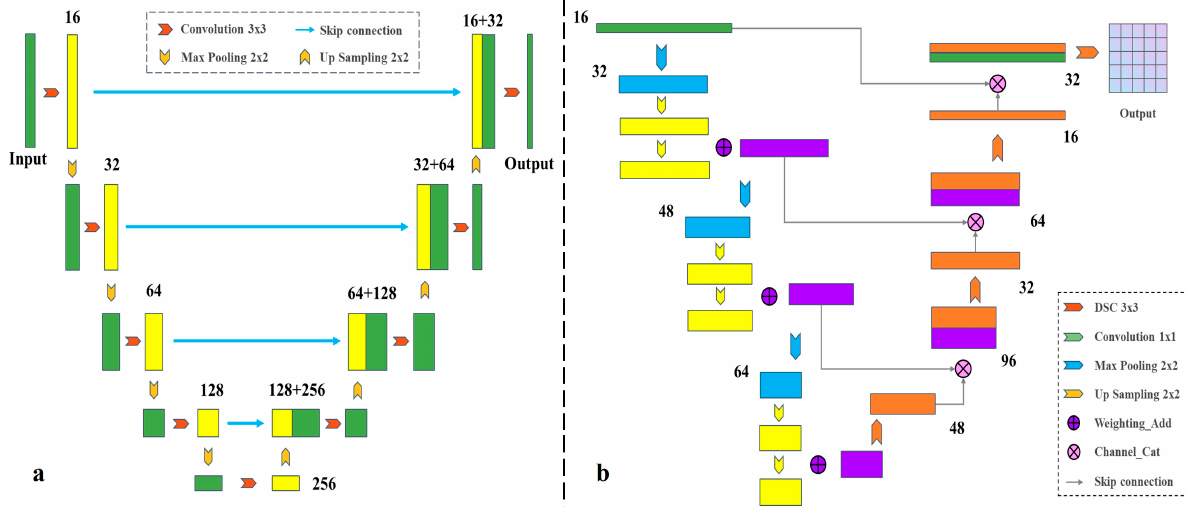
Figure 4. Module structure of ( a ) Unet, and ( b ) deep feature association module.